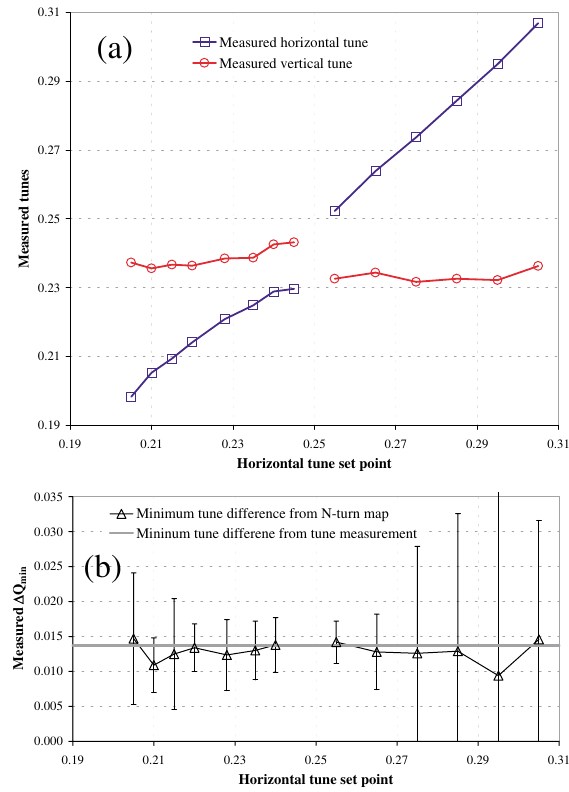
FIG. 3. (Color) Measured tunes as a function of the horizontal obtained from N -turn tune set point in (a). (b) shows the (cid:1) Q min maps, and the computed errors, for the same tune set points. that can be extracted from the Also shown in (b) is the (cid:1) Q min tune measurement depicted in